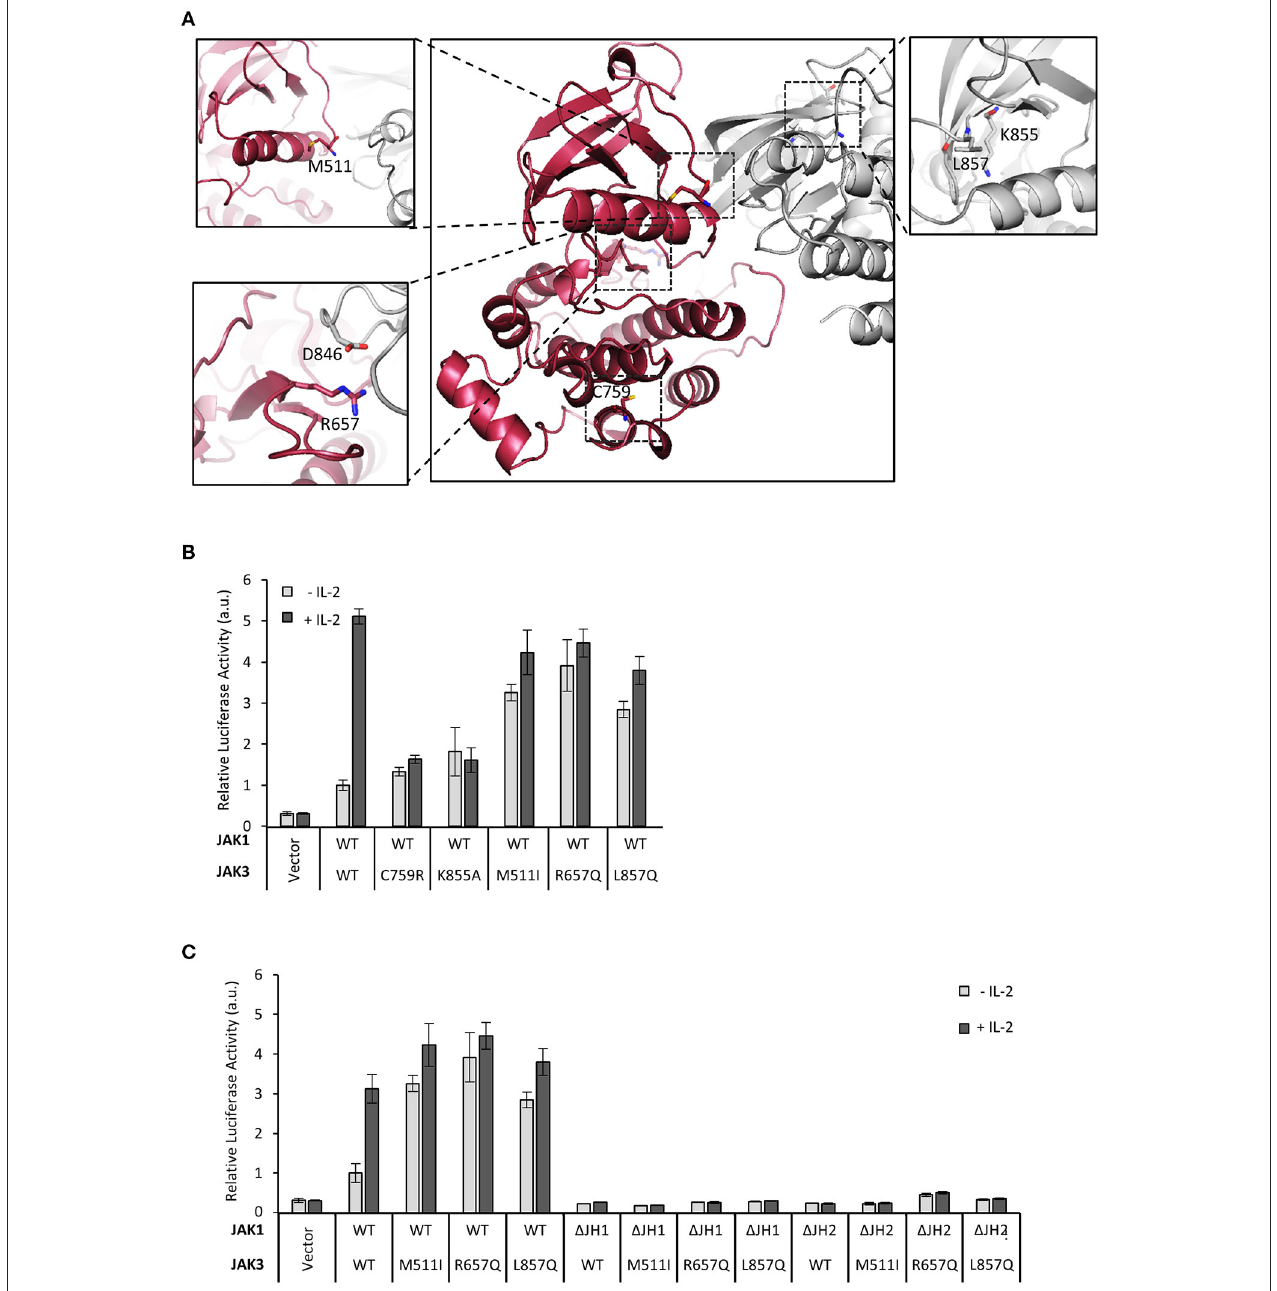
FIGURE 2 | Mutations in JAK3 JH2 can alter the function of the IL-2 pathway. (A) Localizations of the JAK3 mutants used in this article. Homology model of JAK3 JH2-JH1 (based on the TYK2 structure in Protein Data Bank (PDB) code: 4OLI) and the JAK3 JH1 structure [PDB code: 1YVJ (38)] were aligned with the JH1-JH2 structure of TYK2 (PDB code: 4OLI). JH2 is shown in red and JH1 in gray. Close-ups of the mutations are shown in subpanels. C759 is shown in the main picture. In the lower left panel, the (possible) interaction pair R657–D864 (in JH1) is shown. In the right panel, ATP was aligned from ATP-bound form of PKA [PDB code: 1ATP (39)]. (B) JAK3 JH2 C759R mutation efficiently inhibits IL-2 signaling and activating mutations in JAK3 JH2 and JH1. Luciferase assay of STAT5 activation in U4C γβ cells transfected with JAK1 WT and JAK3 point mutations, SPI-luc2 reporter and β -galactosidase control. Values were normalized to JAK1 WT and JAK3 WT transfected sample Errors bars show SD of triplicate samples. Similar results were obtained using pRL-TK as a control. (C) Activating JAK3 mutants rely on both JH1 and JH2 of JAK1 for constitutive downstream signaling. SPI-luc2 reporter was used to detect the activation of STAT5 in U4C γβ cells. Cells were transfected with WT or domain deletion JAK1 and WT or constitutively active JAK3 mutants. β -galactosidase plasmid was used as an internal control for the transfection efficiency. Values were normalized to WT JAK1 and JAK3. Error bars are SD of triplicate